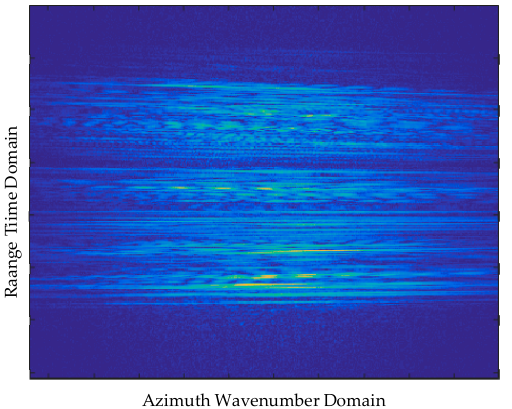
Figure 5. Range space variation of the RCM curves of a moving ship obtained from the GaoFen-3 satellite.